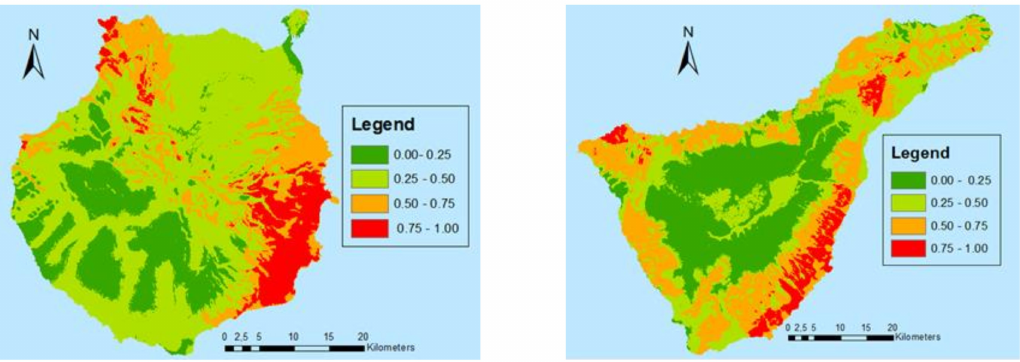
Figure 4. Territorial resource map for the wind energy sector of Gran Canaria and Tenerife.